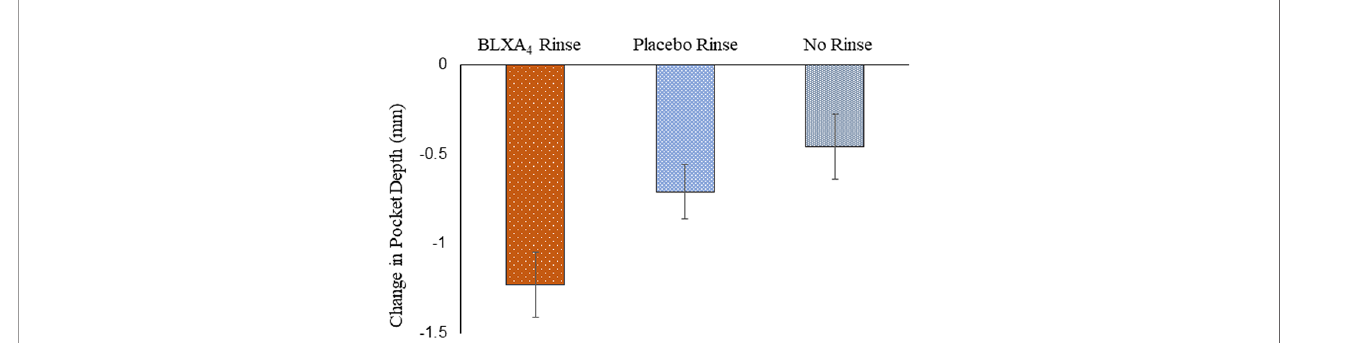
FIGURE 4 | Change in probing depth: Secondary ef fi cacy endpoint. A post-hoc analysis was conducted in a subgroup of subjects exhibiting periodontal disease with pocket depths ≥ 6 mm at baseline. There were 5 subjects in the BLXA4 group, 7 subjects in the placebo group and 5 subjects in the no rinse group. (BLXA4 vs . placebo, p=0.346; BLXA4 vs . no rinse, p=0.199) and (Placebo vs . no rinse p=0.639) by ANCOVA analysis. Note that all subjects had gingivitis with only a limited number of subjects exhibiting